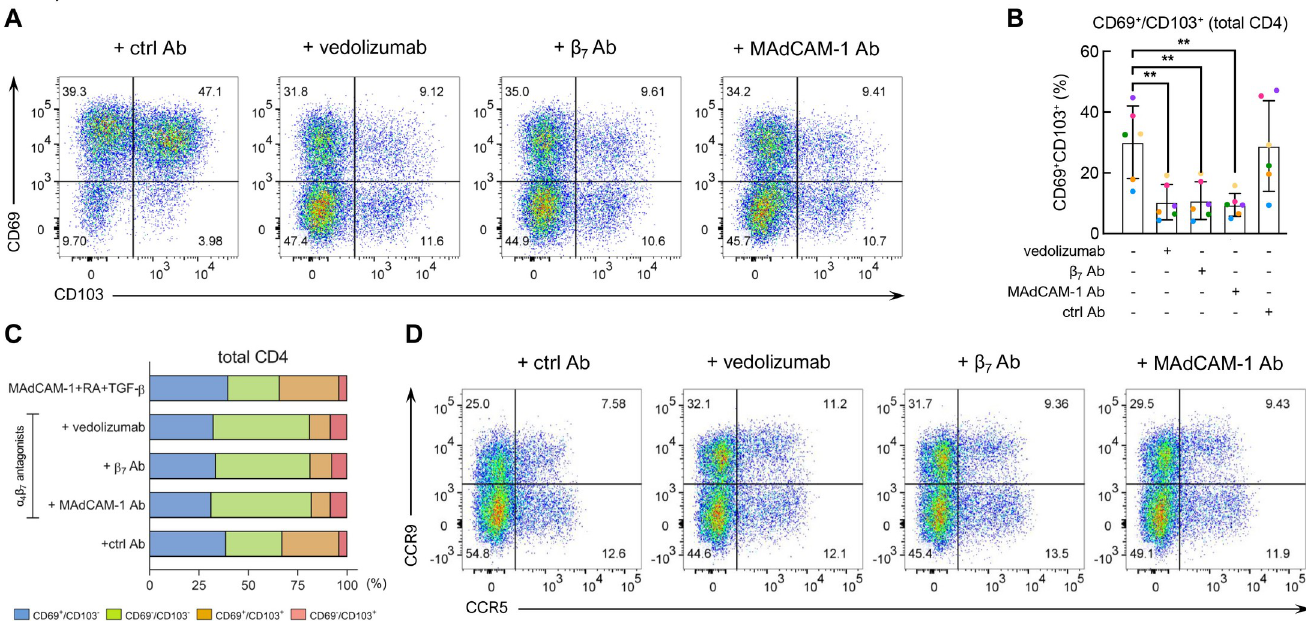
Fig 6. α 4 β 7 antagonists inhibit T RM -like cell differentiation. ( A ) Representative flow cytometry dot plot of CD69 (Y-axis) and CD103 (X-axis) expression following costimulation with MAdCAM-1 + RA + TGF- β in the absence or presence of vedolizumab, β 7 Ab or MAdCAM-1 Ab, as indicated. ( B ) Flow-cytometric analysis of CD69 + /CD103 + CD4 + T cell frequency, as in panel A in 6 independent donors. Y-axis indicates the frequency of CD69 + /CD103 + CD4 + T cells. Inclusion of α 4 β 7 antagonists indicated below. ( �� : P < 0.01, two-tailed t test). ( C ) Bar graph representing the average relative frequencies of CD69 - /CD103 + (red), CD69 + /CD103 + (orange), CD69 - /CD103 - (green), and CD69 + /CD103 - (blue) cell populations in the absence or presence of α 4 β 7 antagonists in six independent donors, as indicated. ( D ) Representative flow cytometry dot plot of CCR9 (Y-axis) and CCR5 (X-axis) expression on total CD4 + T cells following costimulation with MAdCAM-1 + RA + TGF- β in the absence or presence of vedolizumab, β 7 Ab or MAdCAM-1 Ab, as indicated. Percent total cells in each quadrant, as indicated.